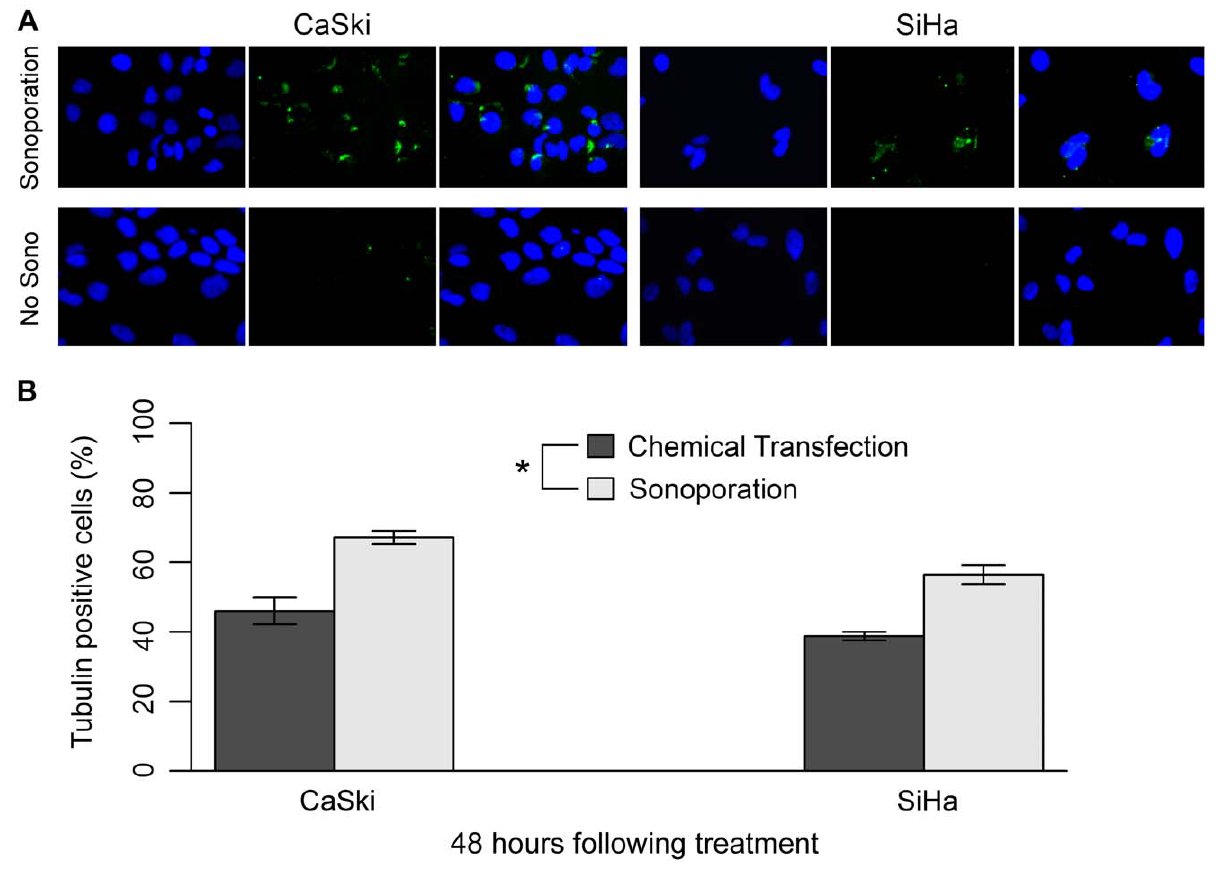
Figure 3. Detection of 4 m g/mL tubulin antibody within CaSki and SiHa cells. (A) Immunofluorescence detection of the tubulin antibody 48 hours following exposure of the cells to sonoporation or sham no HIFU treatment. Nuclei were counterstained blue with DAPI (left photo). Green signal indicates internalized tubulin antibody detected by the application of a secondary fluorophore (centre photo). Images merged (right photo). Cells were visualized using 400 6 magnification. (B) Tubulin antibody positive cells (%) 48 hours following both chemical transfection and sonoporation with 4 m g/mL antibody. Sonoporation resulted in a higher antibody transfection efficiency than that obtained with the traditional chemical reagent, HiPerFect ( P , 0.001, n= 3). Statistical analysis was performed using a two-way ANOVA with Student’s two-sample t-tests post hoc. Error bars represent mean + / 2 SEM. ‘‘*’’ denotes significance.